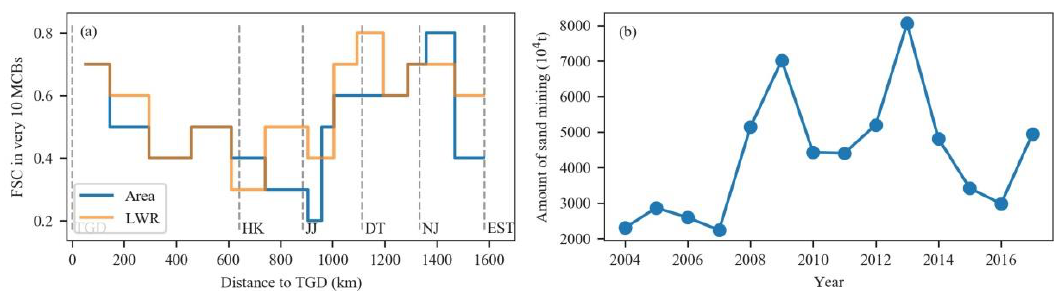
Figure 13. ( a ) Frequency of structural changes (FSC) with distance to TGD. ( b ) The total amount of sand mining in the downstream of TGD.